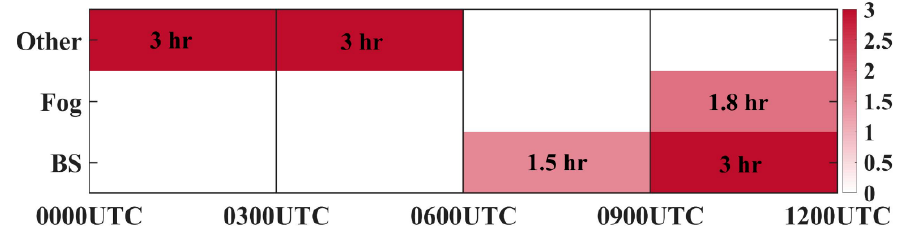
Figure 1. The duration of other situations (Other), fog and blowing snow (BS) every 3 h between 0000 UTC and 1200 UTC on 14 March 2016. Table 2. The number of groups corresponding to different weather phenomena in the training set and the testing set.